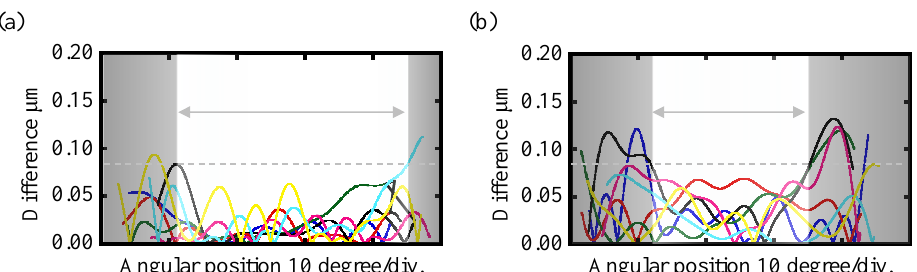
Figure 23. Differences of two neighboring arc-profiles in the overlapped regions obtained by measuring workpieces: ( a ) With a diameter of 3.0 mm; ( b ) With a diameter of 1.5 mm.